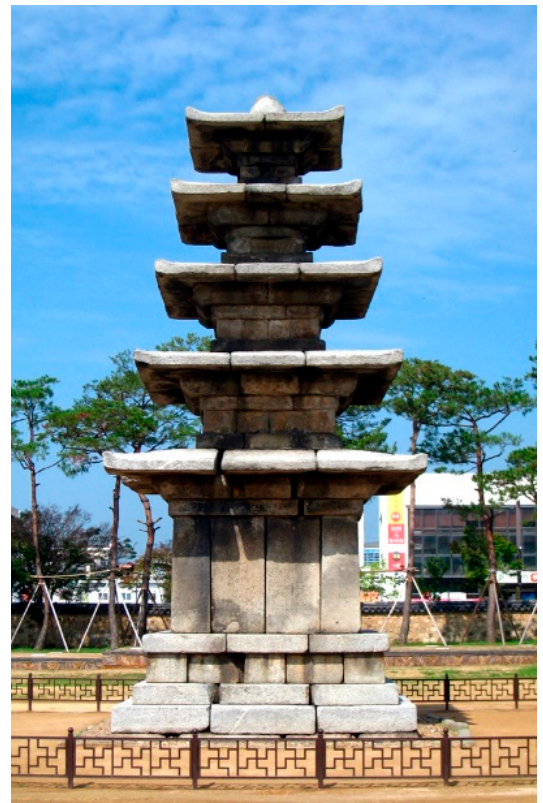
Religions 2019 , 10 , x FOR PEER REVIEW Figure 1. The pagoda at the Ch ŏ ngnimsa Temple [©Photograph by Young Jae Kim]. Figure 1. The pagoda at the Ch˘ongnimsa Temple [©Photograph by Young Jae Kim].